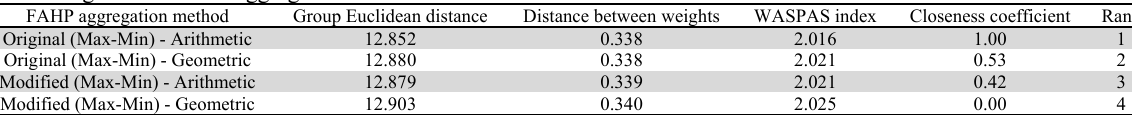
WT rankings of the FAHP aggregation methods FAHP aggregation method Group Euclidean